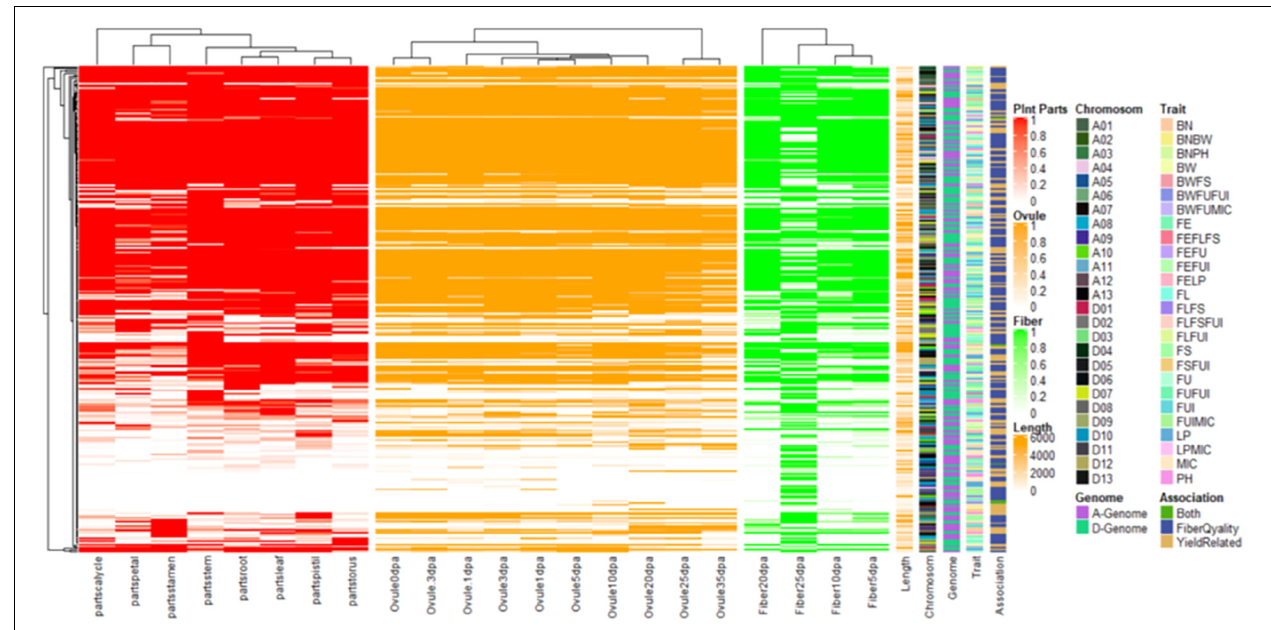
FIGURE 9 | Heat map for expression patterns of the 275 genes nearby significant keys SNPs/QTNs associated with studied agronomic and fiber quality traits. Shaded portion is representing expression > 1 while white portion is representing <